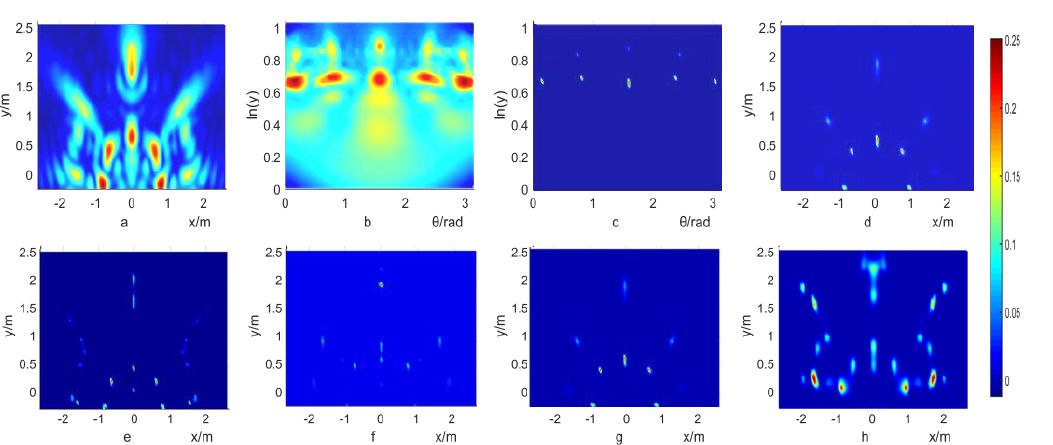
Figure 8. Row above: ( a ) Blur image; ( b ) after log-polar transformation; ( c ) results of the L-R method; ( d ) final result; row below, from left to right: results of ( e ) the direct L-R method; ( f ) polar transformation with the L-R method; ( g ) log-polar transformation with the L-R method (the same as ( d )); ( h ) segmentation with the L-R